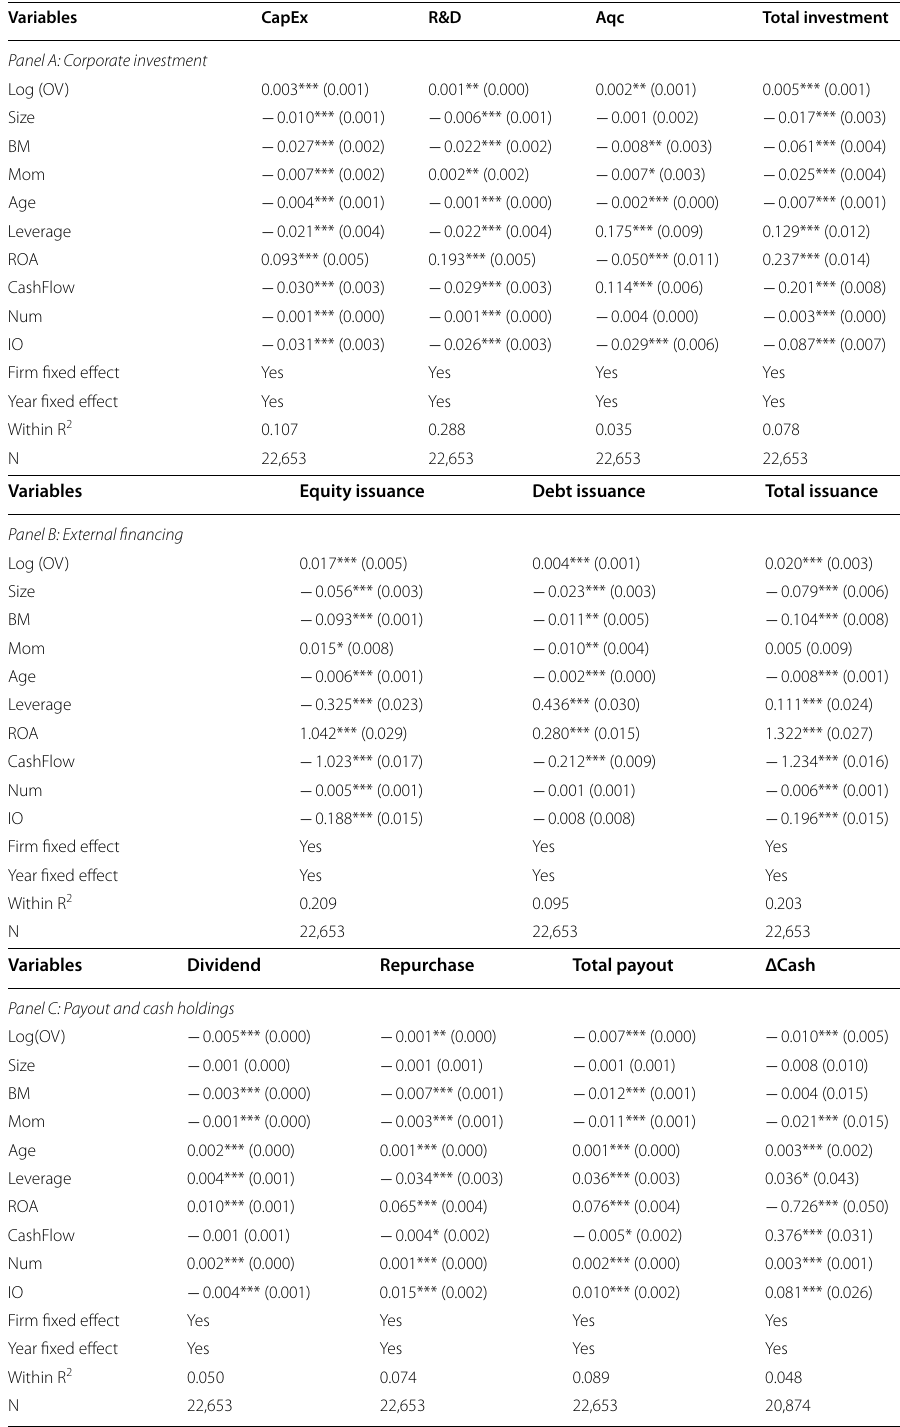
Table 2 The main regression